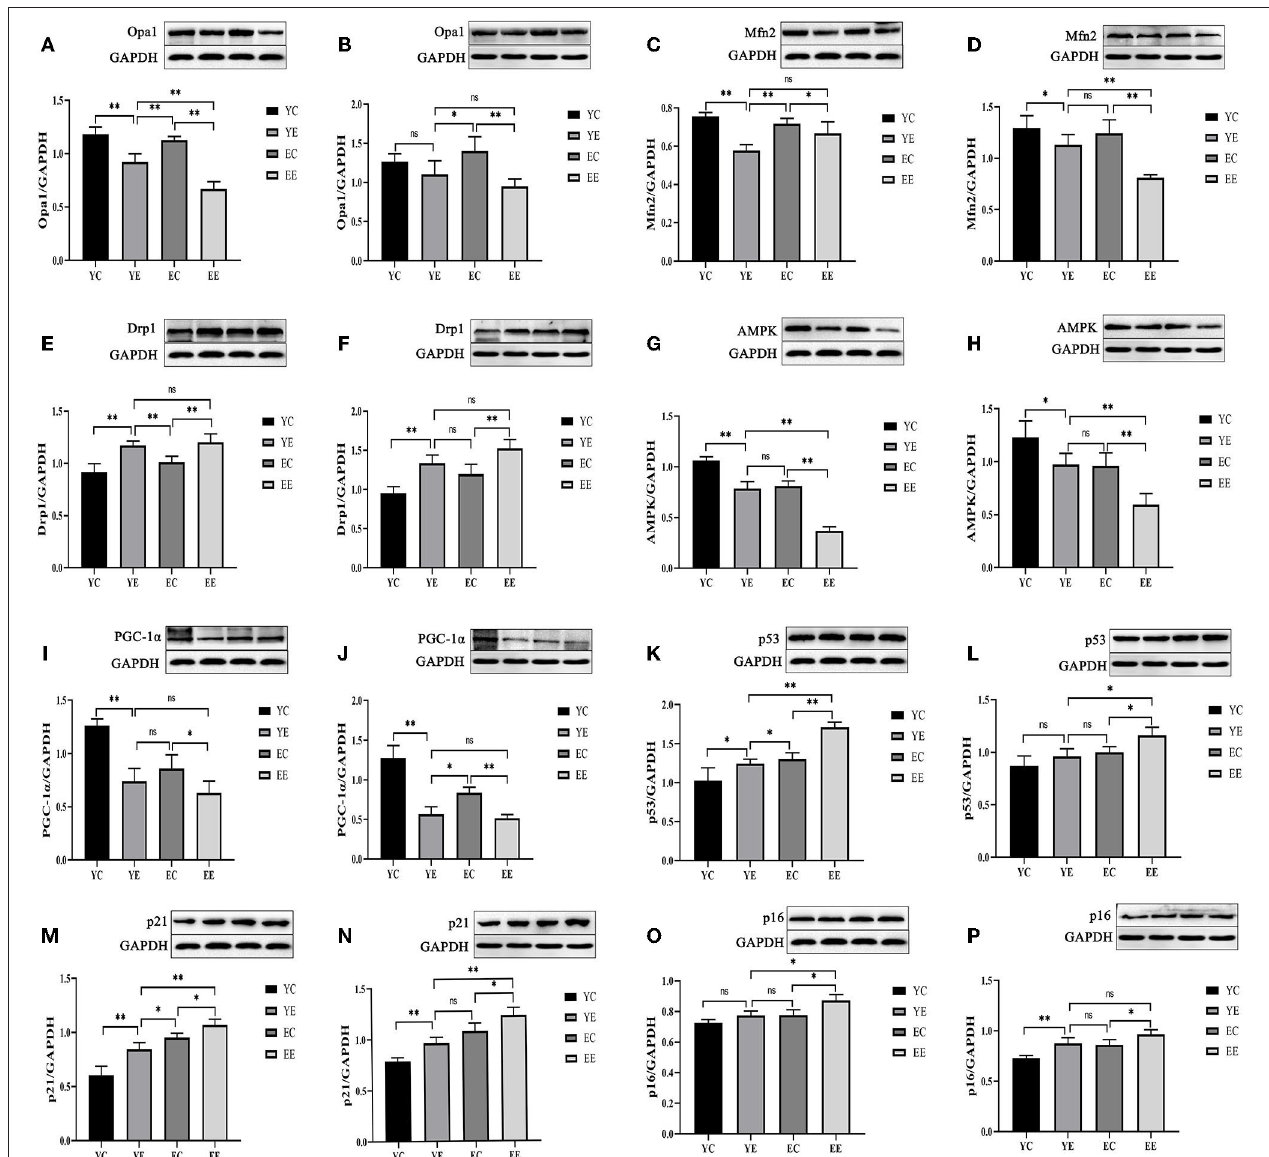
FIGURE 6 | High-fat diet-induced mitochondrial fusion and division, energy stress, and aging in diabetic rats. Protein level of Opa1 (A,B) , Mfn2 (C,D) , Drp1 (E,F) , AMPK (G,H) , PGC-1 α (I,J) , p53 (K,L) , p21 (M,N), and p16 (O,P) . (Liver: A,C,E,G,I,K,M,O ; Skeletal Muscle: B,D,F,H,J,L,N,P ). * p < 0.05, ** p < 0.01, ns p >